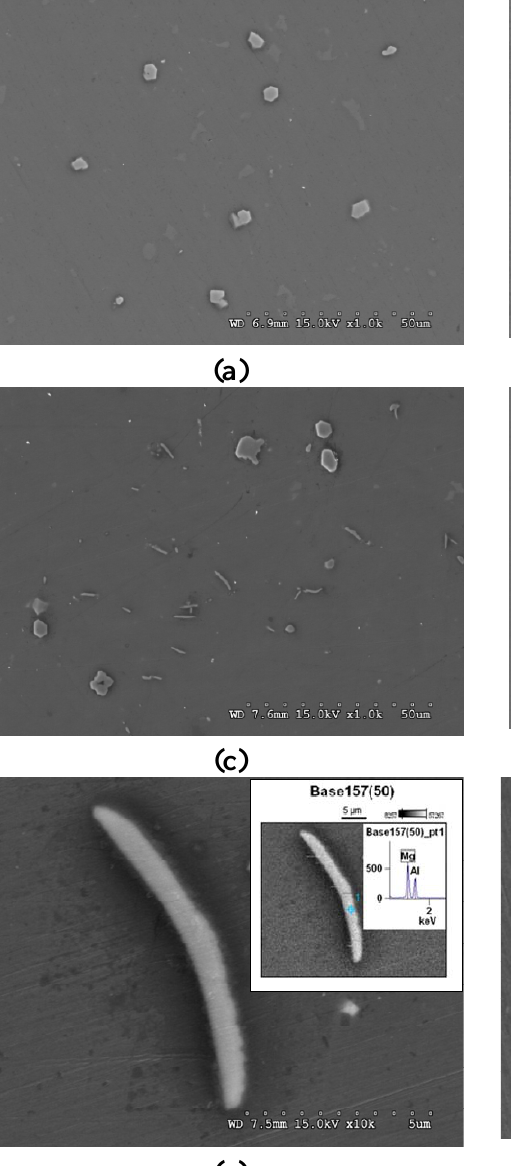
Figure 2. FESEM micrographs showing second phase morphology and distribution in: ( a ) AZ41; ( b ) AZ41 + Y O composite; ( c ) AZ51 and ( d ) AZ51 + Y 2 3 ( e ) EDS (Energy-dispersive X-ray Spectroscopy) analysis on the needle-shaped O reinforcement in ( f ) AZ41/Y intermetallic; the presence of individual Y 2 3 and ( g ) AZ51/Y O 2 3